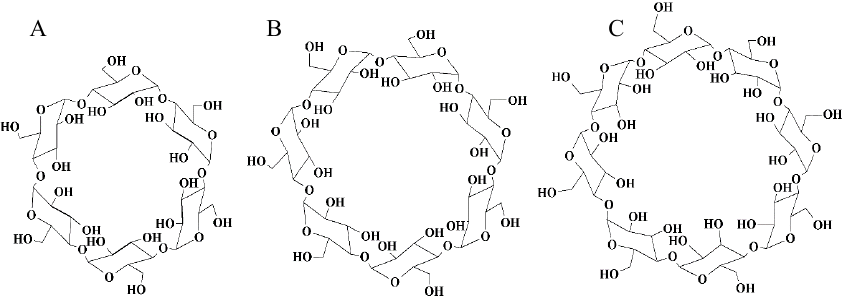
Figure 1. Schematic representation of the structure of alpha‐ ( A ) beta‐ ( B ) and gamma‐ ( C ) cyclodextrin.